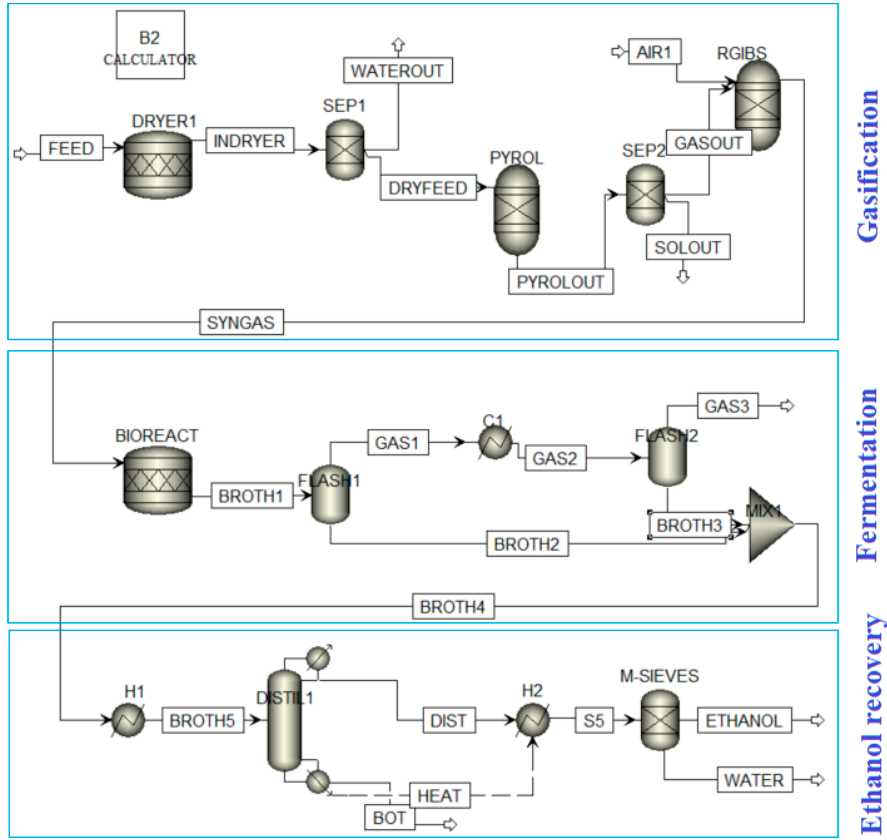
Figure 1. Aspen Plus flow chart of the system.